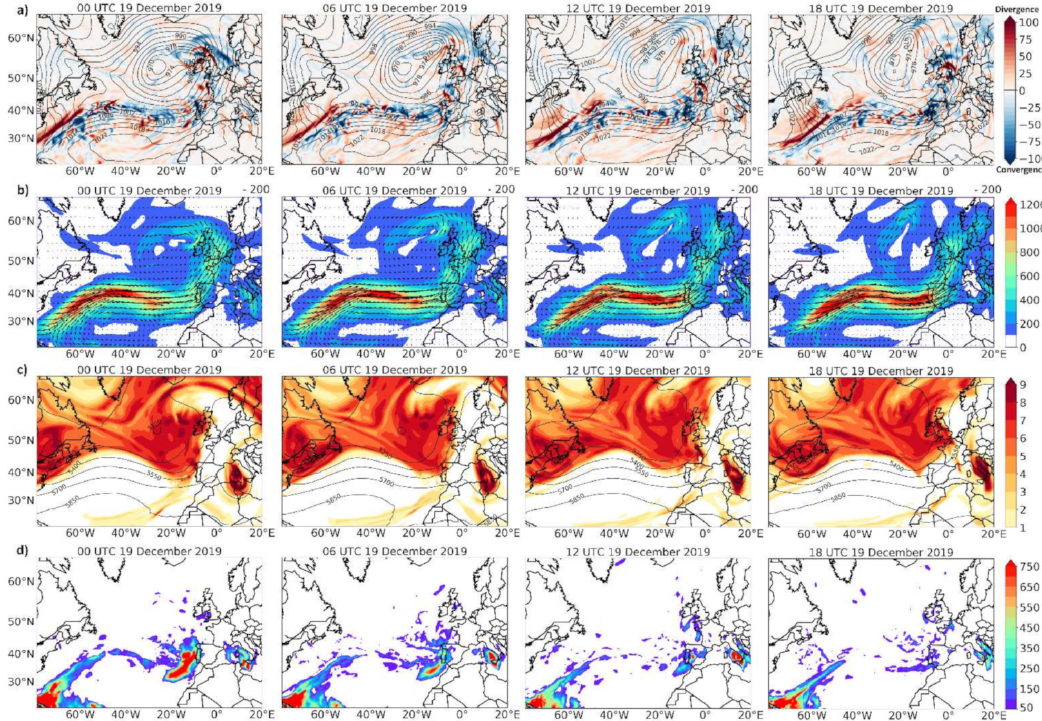
Figure 3. As Figure 2 but for the storm Elsa on 19 December